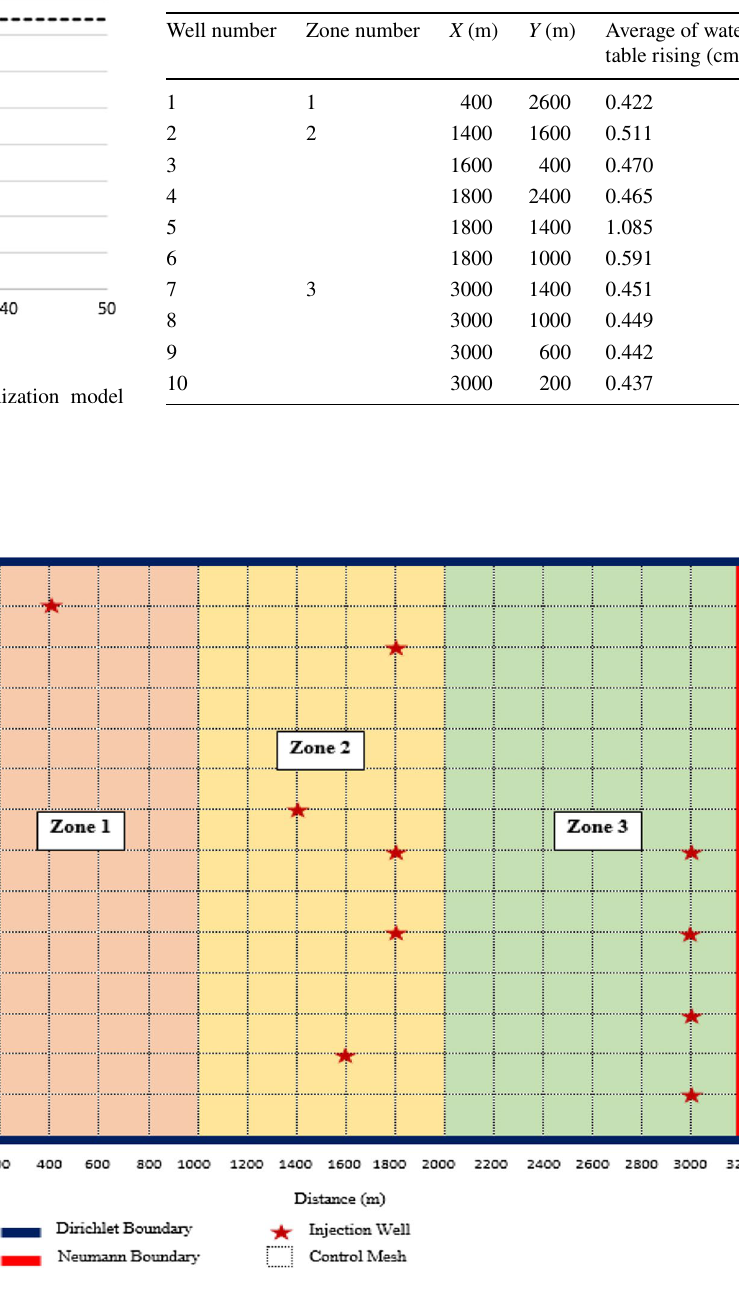
Table 6 Average of water table rising in each injection well